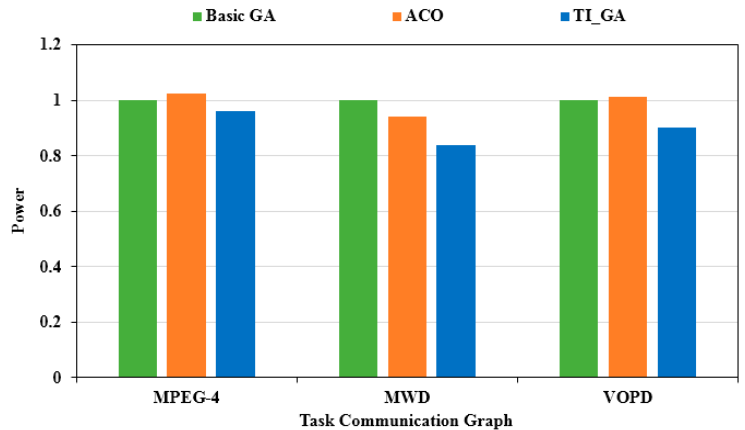
Figure 10. TI_GA, traditional genetic algorithm and ACO for MPEG-4, MWD, VOPD power results comparison ( μ e : μ d = 2:1).